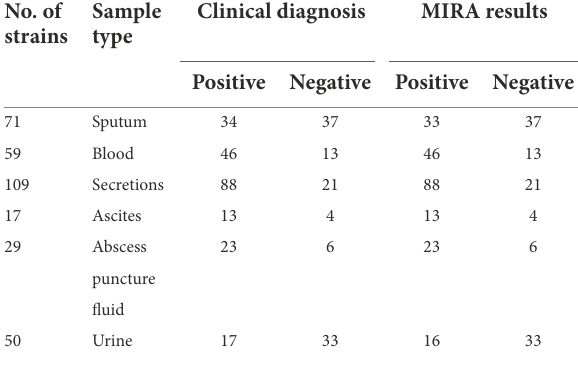
TABLE 2 Information on clinical isolates ( S. aureus strains and non- S. aureus